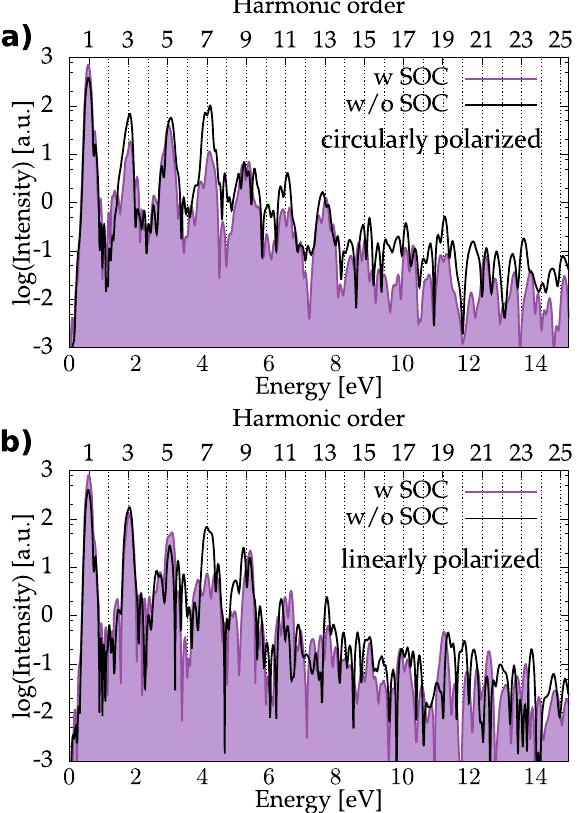
Fig. 5 Effect of SOC on the HHG spectra. Calculated HHG spectra with (violet curves) and without SOC (black curves) for ( a ) a laser RHS circularly polarized in the y − z plane, and ( b ) a laser linearly polarized along the y axis. Similar to the other simulations, we employ here a laser pulse of 25 fs duration, a carrier wavelength λ of 2100 nm, and an intensity of I = 4 × 10 11 W.cm − 2 .